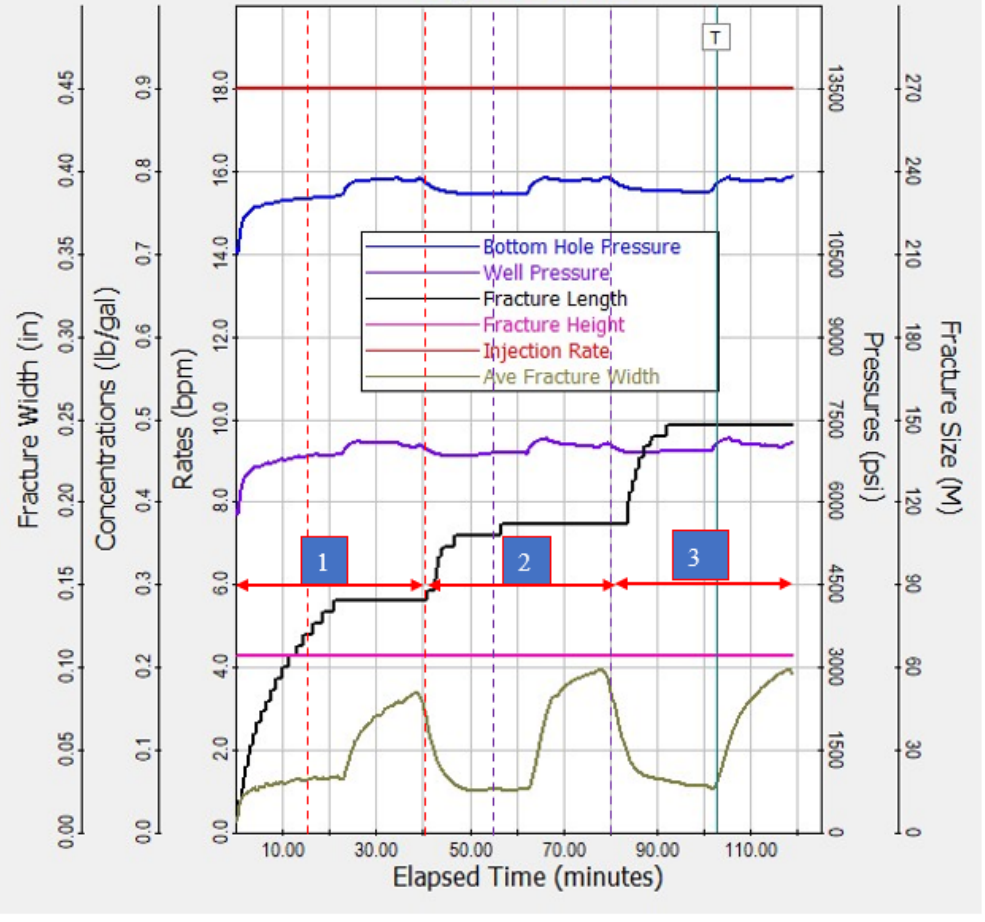
Figure 11. Pumping schedule for optimized condition with 90 K-gal fluid volume, 18 BPM injection rate and three (3) stages.